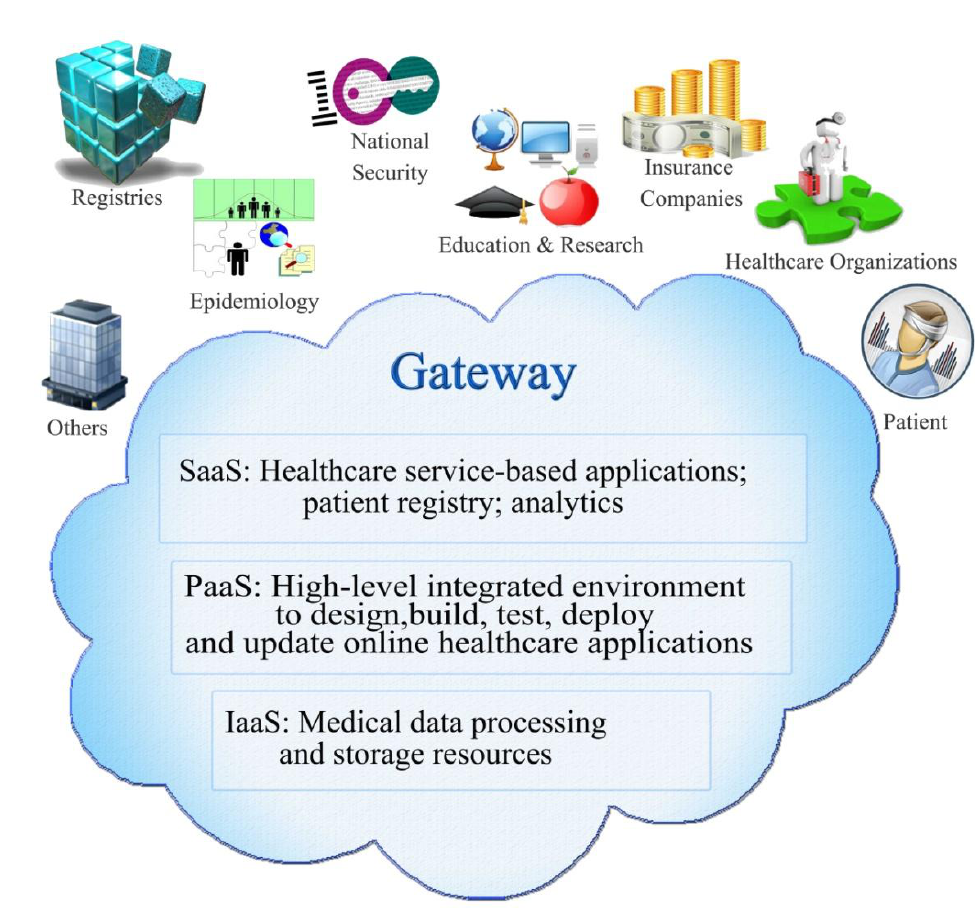
Figure 1. The generic architecture of e-Health